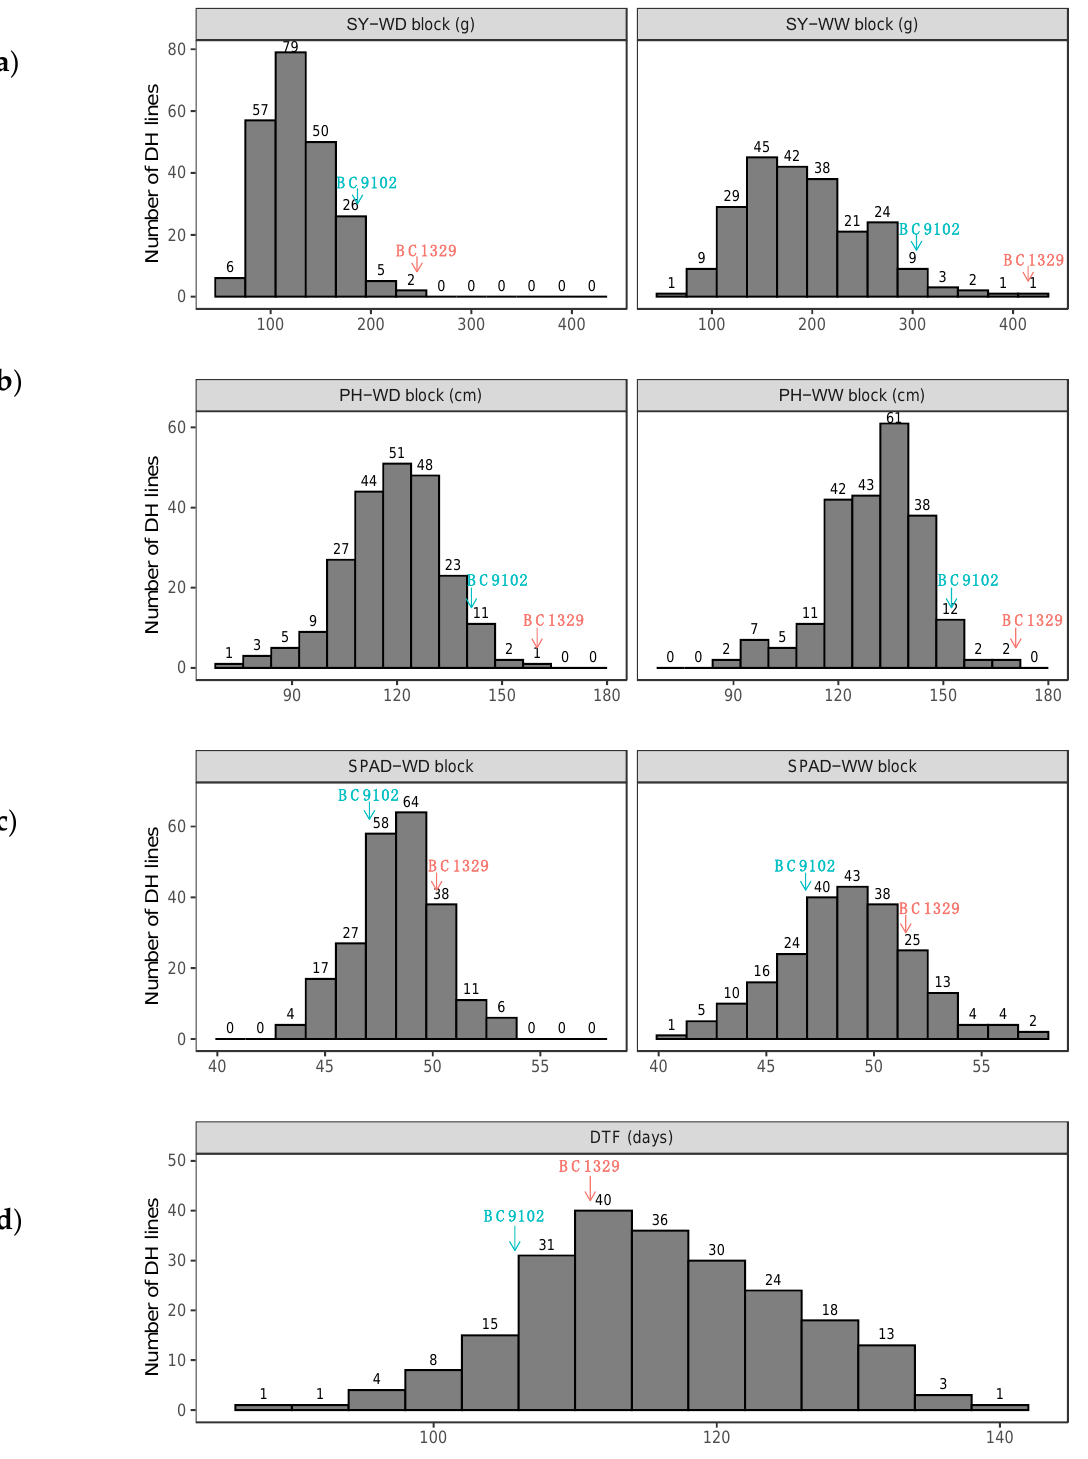
Figure 1. Frequency distributions of the traits for 223 DH lines from the BC1329/BC9102 breeding population grown in two contrasting water regimes: well-watered (WW) and water-deficit (WD) conditions under a rainout shelter at Wagga Wagga Agricultural Institute. Estimates for the parental lines are shown with arrows. ( a ) SY: Seed yield; ( b ) PH: Plant height; ( c ) SPAD: Chlorophyll content; ( d ) DTF: Days to flower. Total (additive plus non-additive) common genotype by environment empirical best linear unbiased predictions are used for the traits SY, PH, and SPAD, and total genotype empirical best linear unbiased predictions are used for DTF for the frequency distributions.